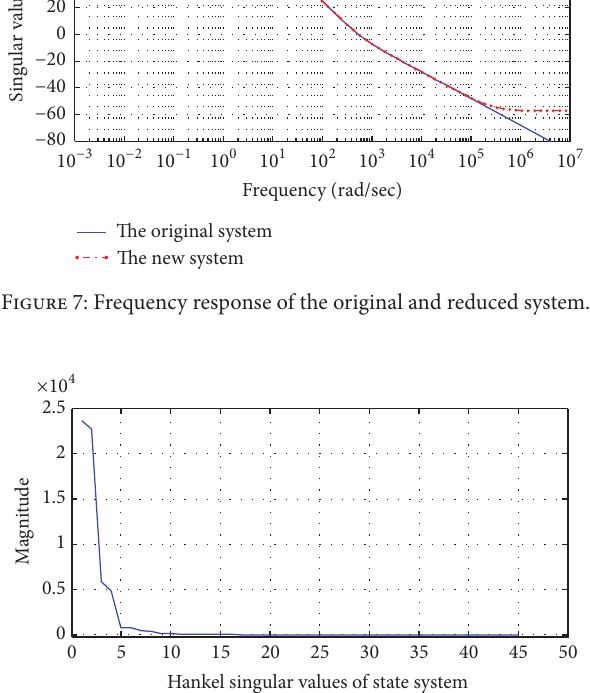
Figure 8: Distribution of Hankel singular